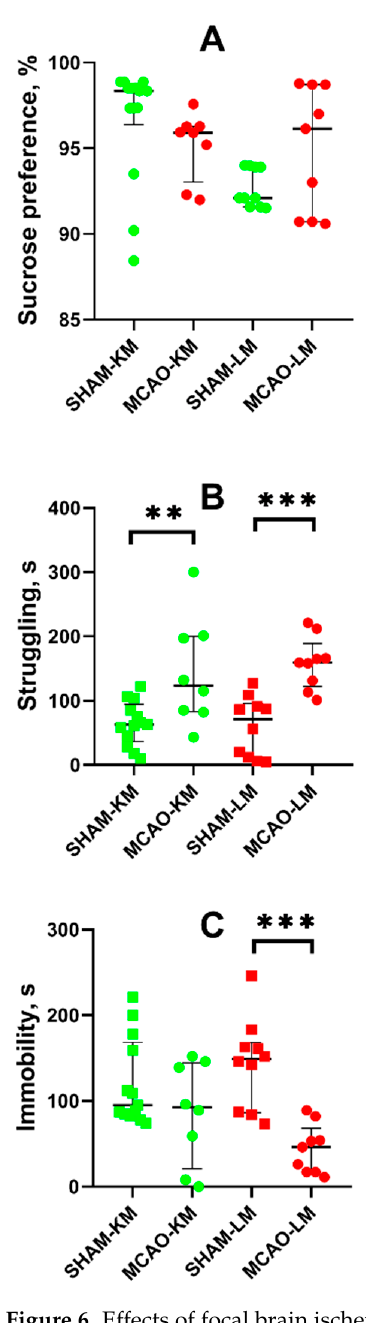
Figure 6. Effects of focal brain ischemia on behavior of MCAO-KM and MCAO-LM groups in the sucrose preference ( A ) and forced swim tests ( B , C ) 3 months after surgery. ( A ) Sucrose preference. ( B ) Struggling behavior. ( C ) Immobility duration. ** p < 0.01 and *** p < 0.005 (Mann–Whitney U test).